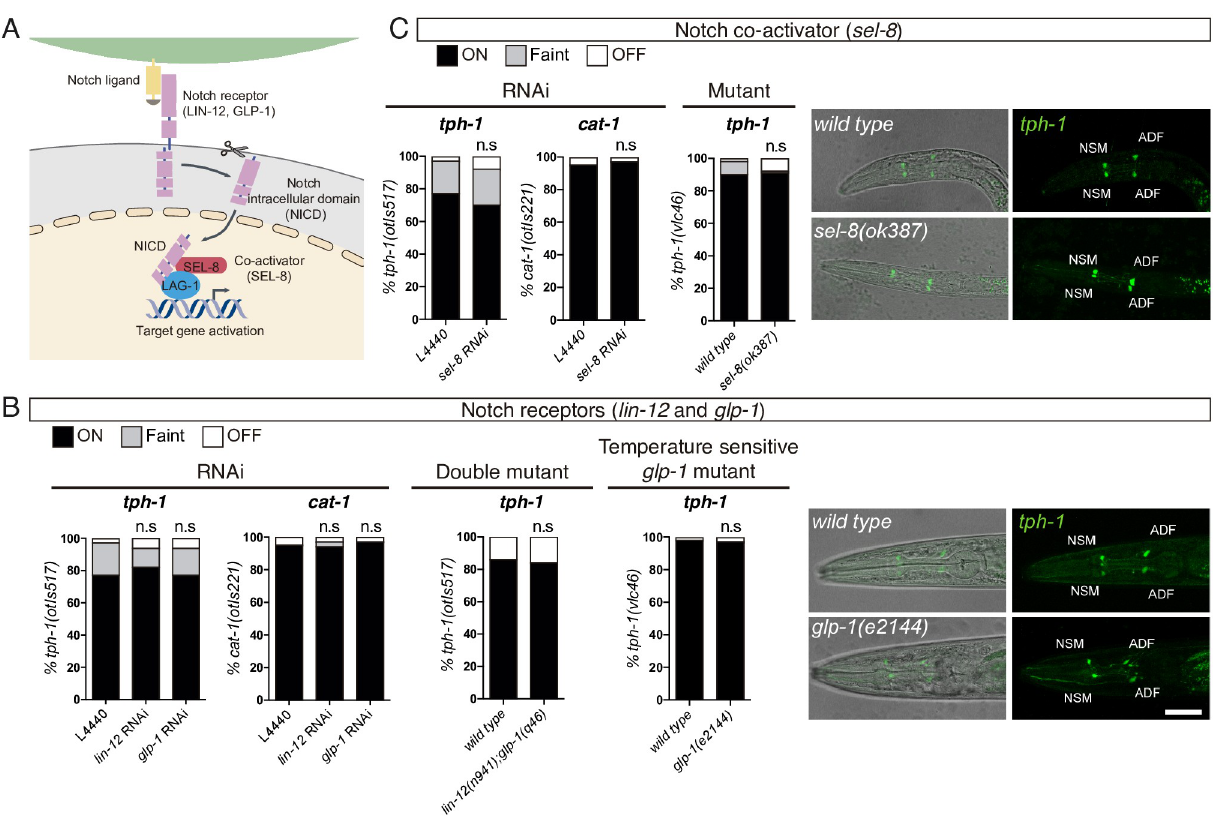
Fig 6. glp-1 and lin-12 Notch receptors and sel-8 coactivator are not required for ADF specification. (A) Schematic representation of Notch signalling pathway in C . elegans . (B) P0 RNAi and double mutant analysis for glp-1 and lin-12 Notch receptors and temperature-sensitive allele analysis for glp-1 show no significant difference in tph-1(otIs517) and cat-1(otIs221) reporter expression in the ADF neuron. L1 stage confocal images showing representative examples of the temperature shift assay. Scale bar: 15 μ m. See S1 Data for numerical values of all replicates and temperature-sensitive allele scoring at YA stage. (C) P0 RNAi and mutant analysis of sel-8 coactivator shows no difference in tph-1(otIs517) and cat-1(otIs221) reporter expression in the ADF neuron. L1 stage confocal images showing representative examples. See S1 Data for numerical values. L1, first larval stage; NICD, Notch intracellular domain; n.s, nonsignificant; YA, young